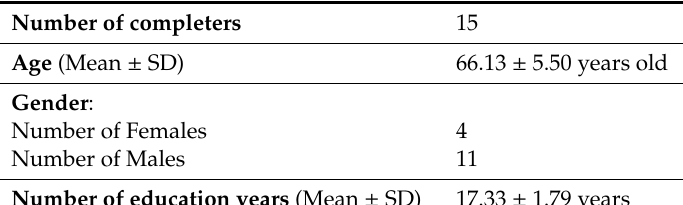
Figure 1. Consort diagram showing the recruitment, exclusion, and inclusion numbers (DRAT: Delayed-Response Alphabetization Task). Table 1. Baseline demographic for included participants.